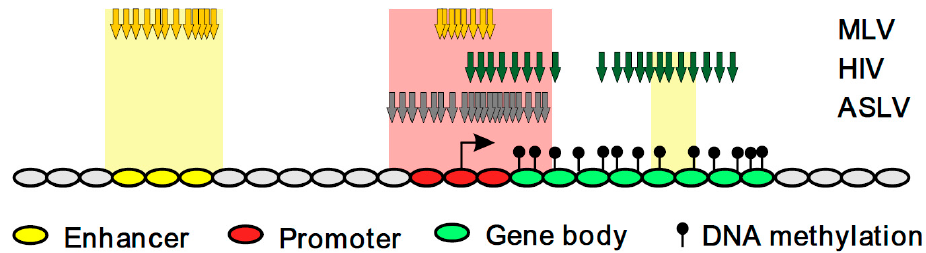
Figure 7. The model recapitulating the distribution of stably active proviruses with regard to the genomic and epigenomic features of the integration sites. Yellow arrows, MLV; green, HIV, blue, ASLV.